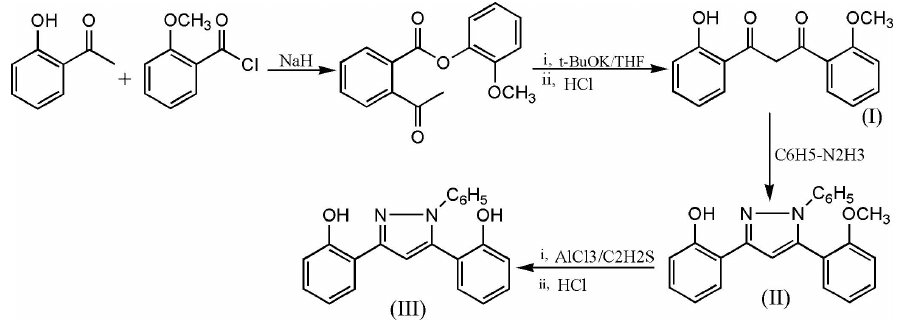
Figure 3 Preparation of the title